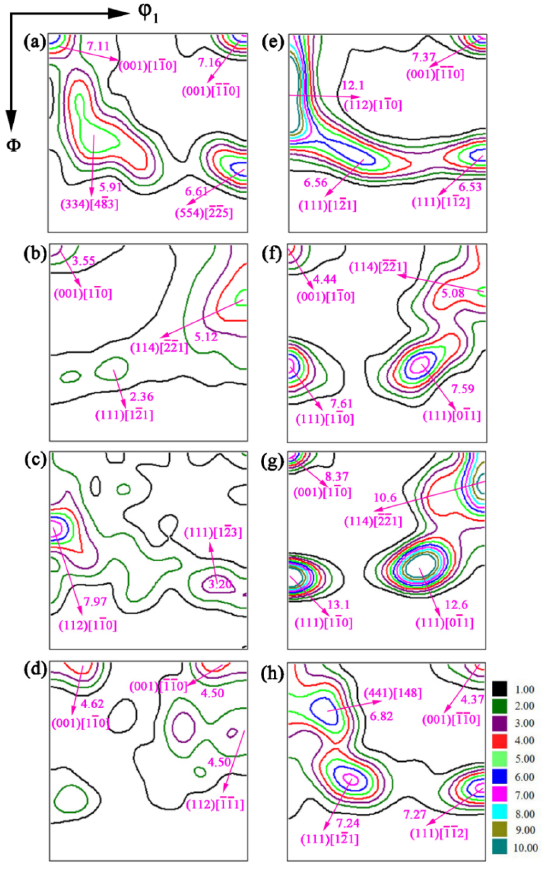
Figure 8. ODFs ( φ 2 = 45° sections) of X2CrNi12 steel at 50% deformation ( a – d ) and 90% deformation Figure 8. ODFs ( ϕ 2 = 45 ◦ sections) of X2CrNi12 steel at 50% deformation ( a – d ) and 90% deformation ( e – h ) with different annealing temperatures, ( a , e ) deformed; ( b , f ) 720 °C; ( c , g ) 740 °C; ( d , h ) 770 °C. ( e – h ) with different annealing temperatures, ( a , e ) deformed; ( b , f ) 720 ◦ C; ( c , g ) 740 ◦ C; ( d , h ) 770 ◦ When the cold-rolling reduction is 90%, the specimen of the 90%-deformed steel is mainly composed of the strong α -fiber at (112)[1 1(cid:3364) 0] with f(g)max = 12.1 and the weak γ - fiber at (111)[1 2(cid:3364) 1] and (111)[1 1(cid:3364) 2], and the maximum intensity f(g)max = 6.56 (Figure 8e). When the annealing temperature is 720 °C, the textures of (112)[1 1(cid:3364) 0] and (001)[ 1(cid:3364)1(cid:3364) 0] dis- appear, forming the (001)[1 1(cid:3364) 0] and (114)[ 2(cid:3364)2(cid:3364) 1] textures (Figure 8f). The α -fiber texture is weakened and the γ -fiber texture is enhanced. The highest intensity among the γ -fiber texture is at {111} 〈 110 〉 . As shown in Figure 8g, the texture of the 90%-740 °C steel is con- sistent with the specimen at 90%-720 °C, but the maximum intensity of the α -fiber texture at (001)[1 1 (cid:3364) 0] increases to 8.37, and the intensity of the γ -fiber textures increase to 13.1 for (111)[1 1(cid:3364) 0] and 12.6 for (111)[0 1(cid:3364) 1], respectively. According to the literature, the formation of high-density γ -fiber texture in a stainless steel plate is beneficial to improve the forma- bility of the material [24,25]. As annealing temperature increased to 770 °C, the α -fiber